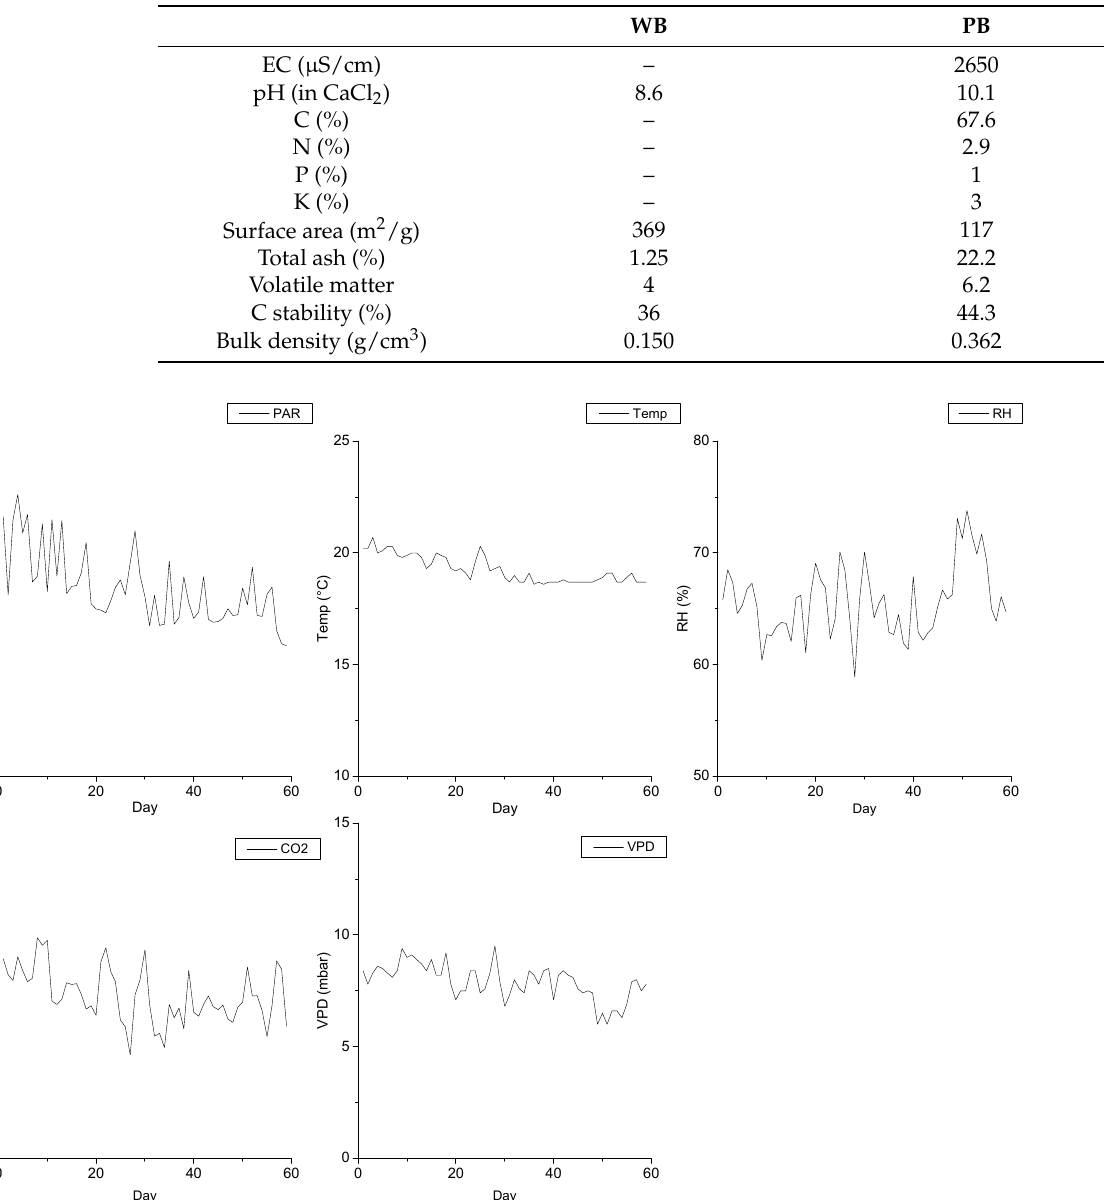
Table 1. Basic information of the two biochar types—wood biochar (WB) and poultry manure biochar (PB).